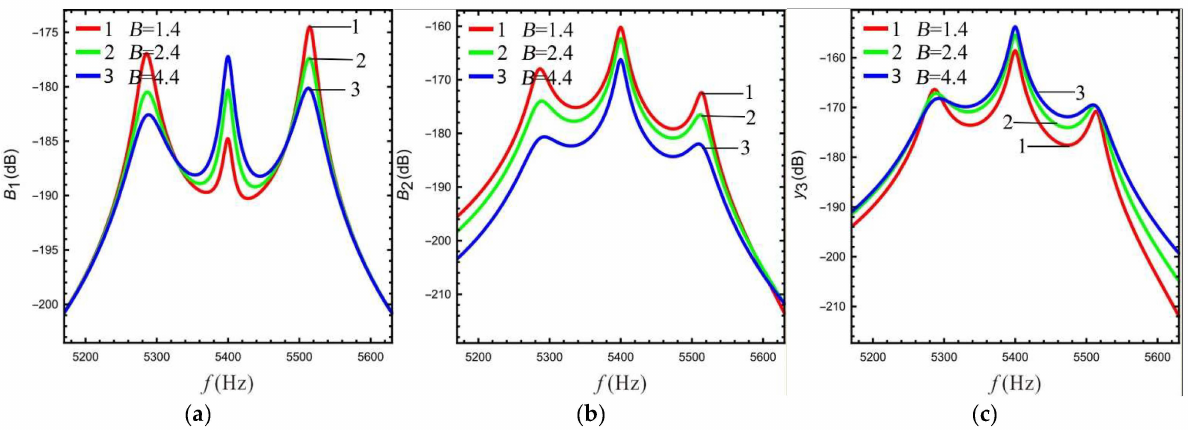
Figure 6. The relationship between gain and LR in sense mode: ( a )Sense-I, ( b ) Sense-II (at lever input), ( c ) Sense-II (at lever output).